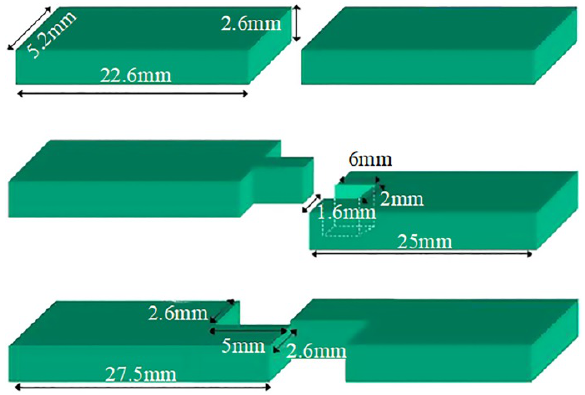
Fig. 2 Three different joint configurations for the 4- point bending test. Reproduced with permission from Ref. [18], © Elsevier B.V. 2008.